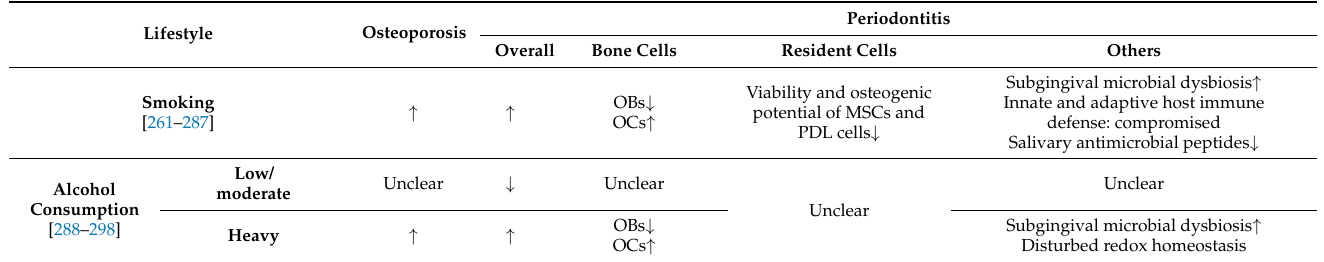
Table 3. Impact of lifestyle on osteoporosis and